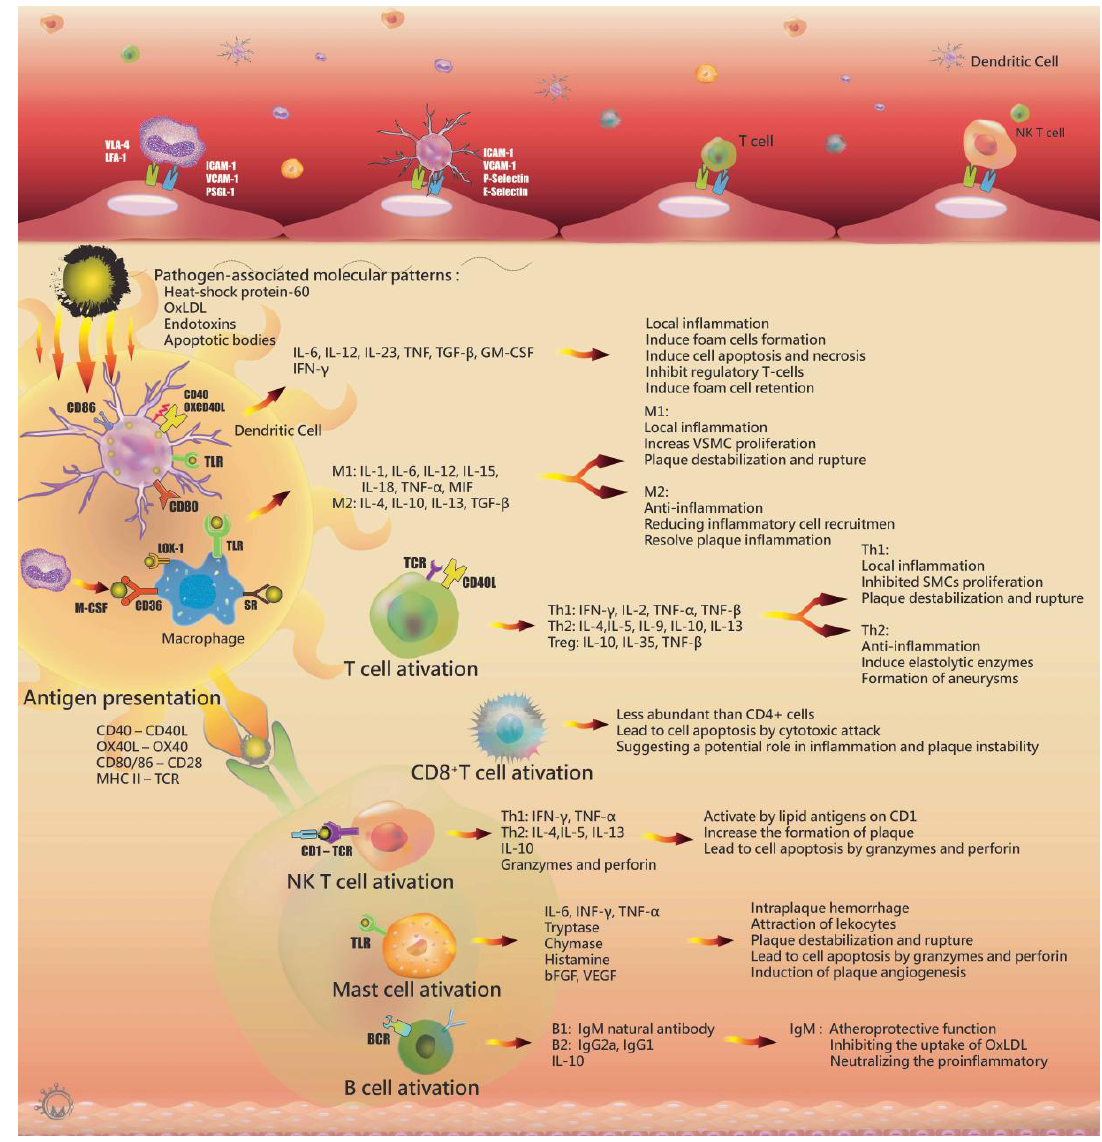
Figure 3. The role of inflammatory cells in atherosclerotic lesion.